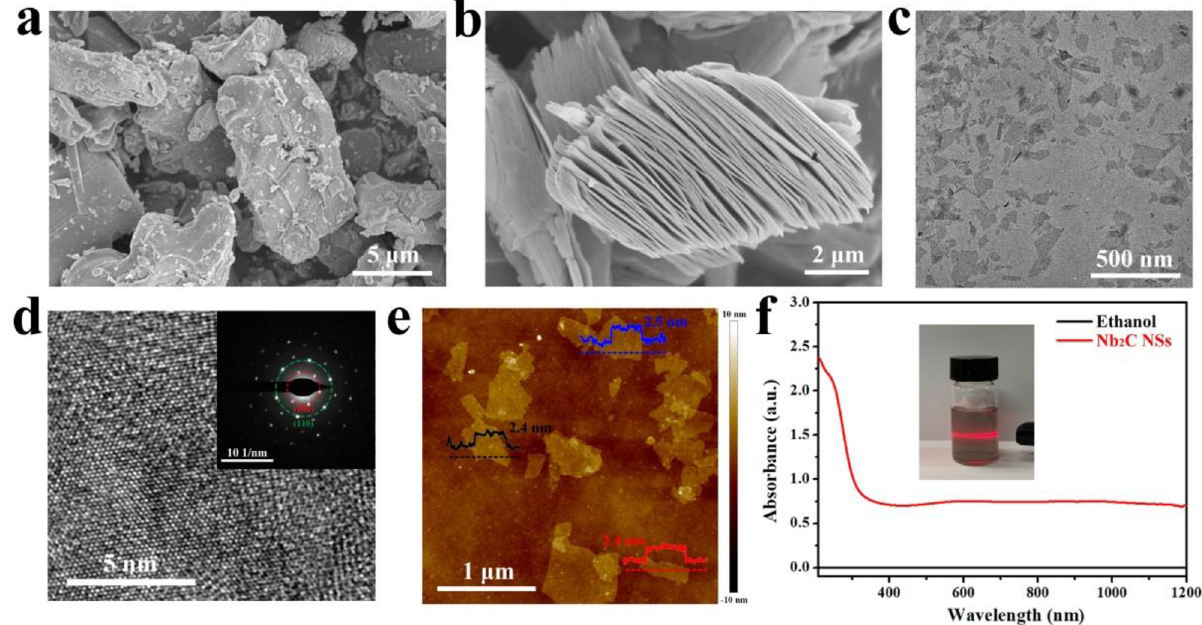
Figure 1: (a) Scanning electron microscope (SEM) image of Nb 2 AlC MAX powder. (b) SEM image of hydro fl uoric acid-etched Nb 2 C MXene. (c) Transmission electron microscope (TEM) image of few-layer Nb 2 C nanosheets (NSs). (d) High-resolution TEM image of few-layer Nb 2 C NSs.